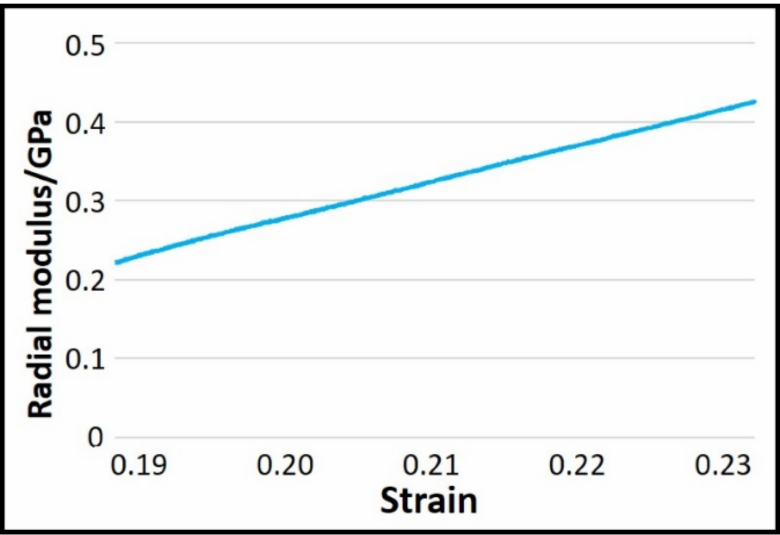
Figure 7. Radial modulus of the Kevlar